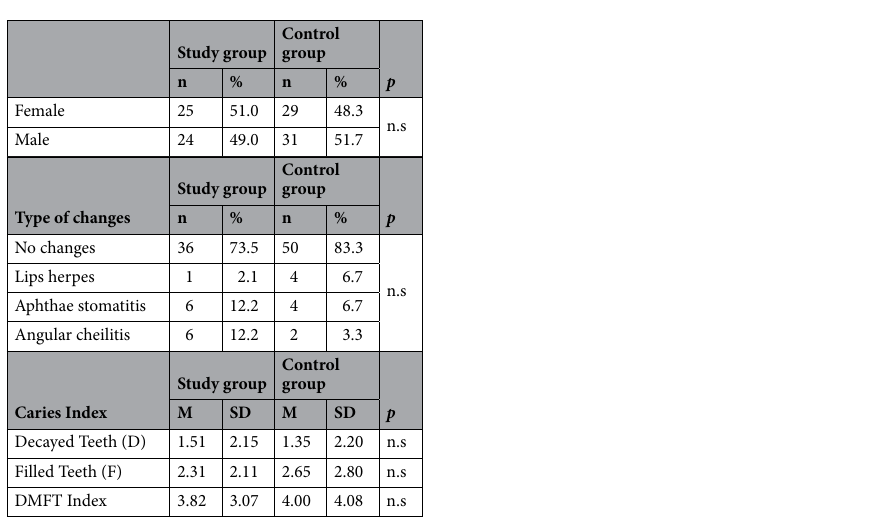
Table 1. Characteristics sex, changes in the oral mucosa and tooth caries in the study and control groups.